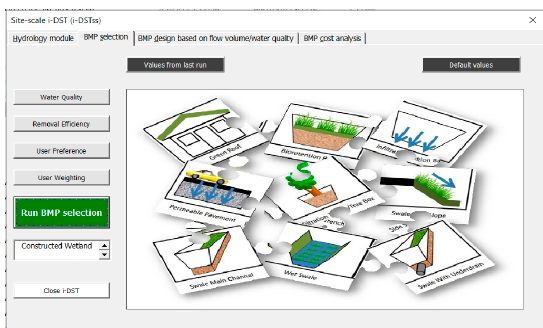
Figure A13. User weighting option